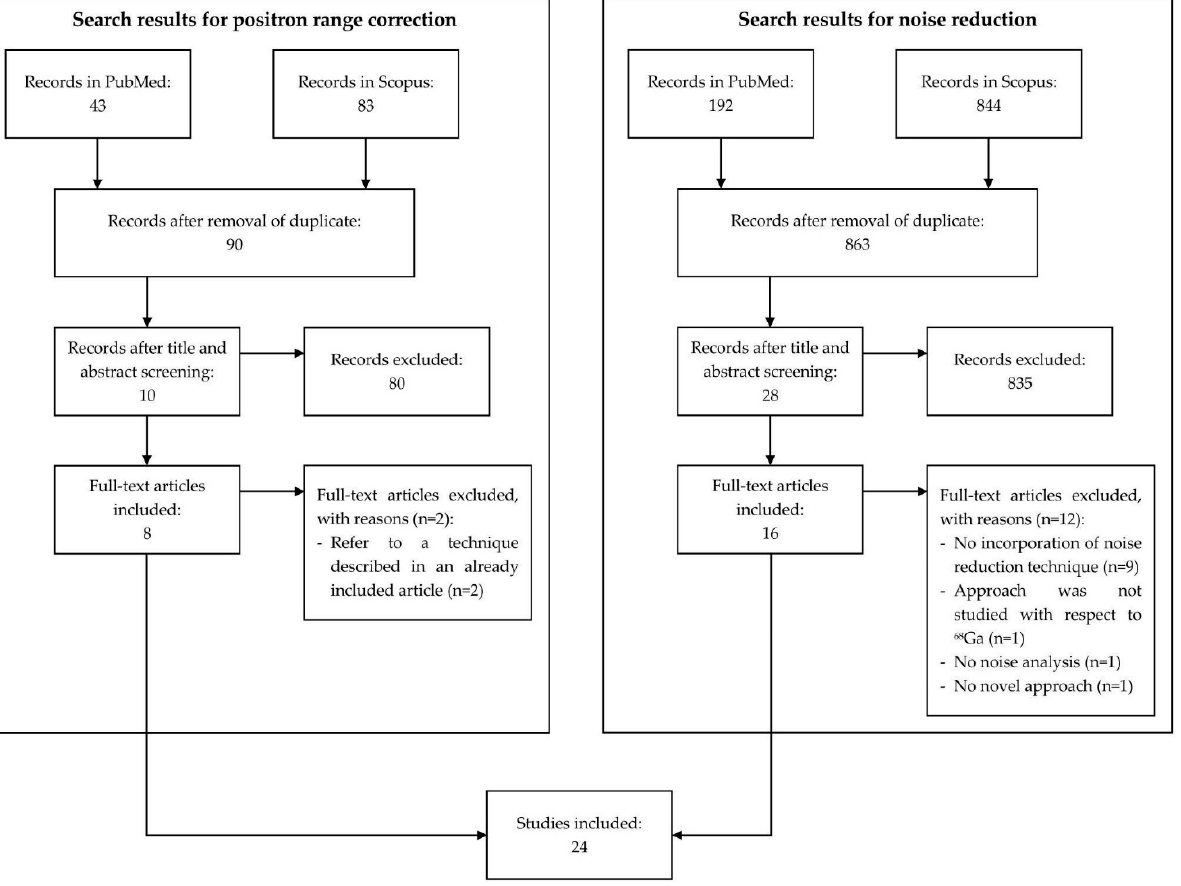
Figure 1. Chart illustrating the screening process of the literature review.